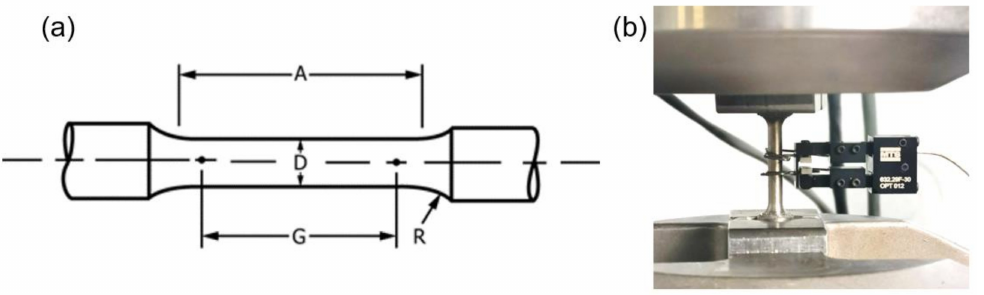
Figure 4. LPBF of Inc718; ( a ) tensile samples geometry, according to ASTM E8 (A = 20 mm, D = 4 mm, G = 16 mm, R = 4 mm), ( b ) tensile test set